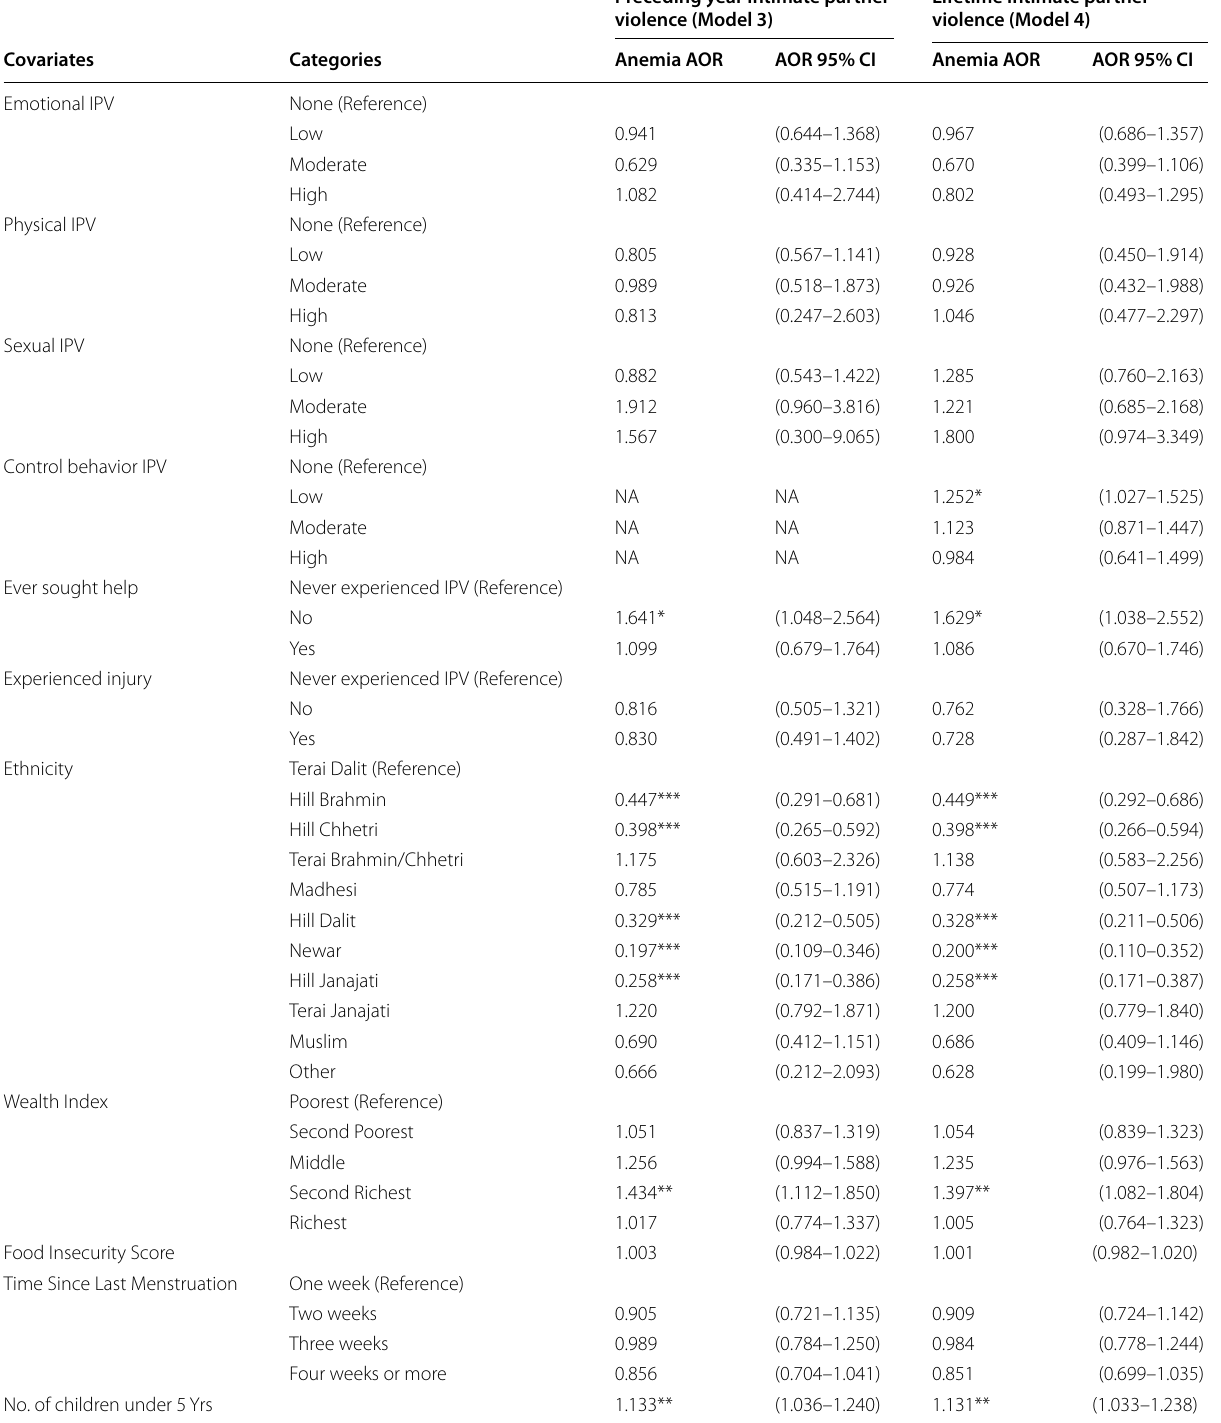
Table 3 Multivariate logistic regression models: intimate partner violence and